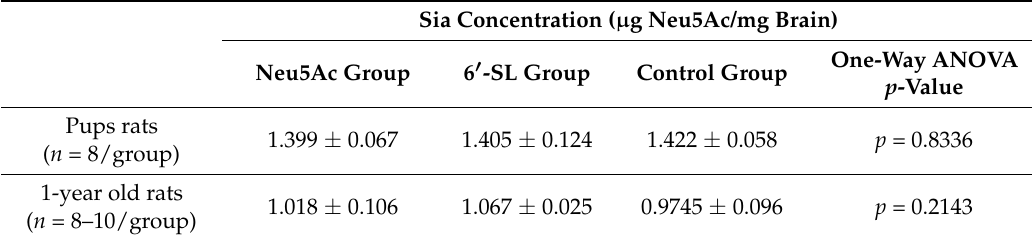
Table 1. Concentration of Sia ( µ g Neu5Ac/mg) in brain in weaned and 1-year old rats supplemented with different Sia sources or water during the lactation period. Data are the mean ±